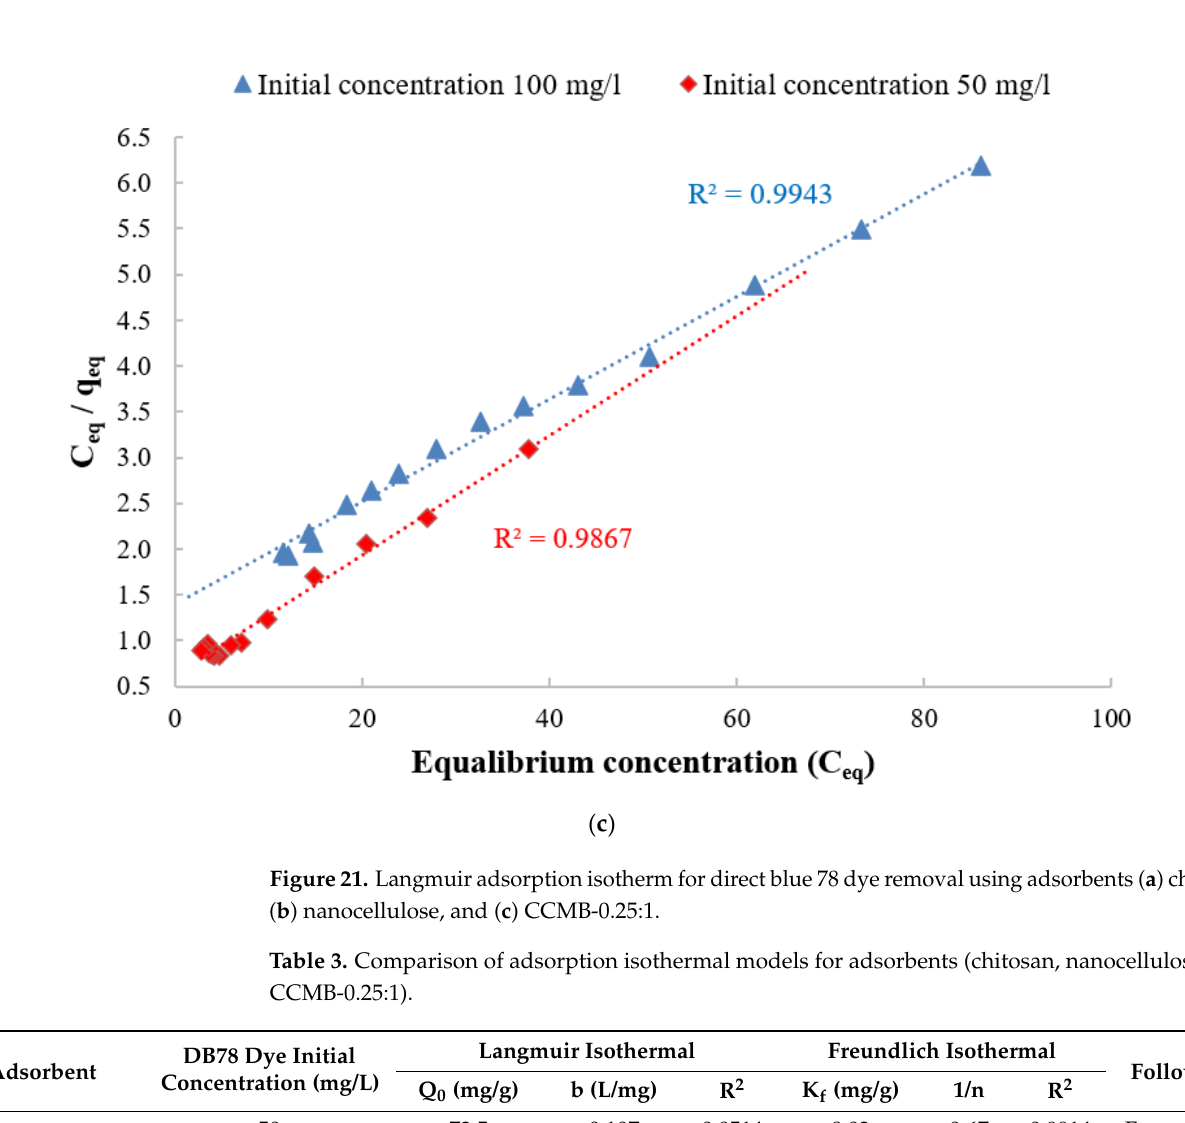
Table 3. Comparison of adsorption isothermal models for adsorbents (chitosan, nanocellulose, and CCMB-0.25:1).